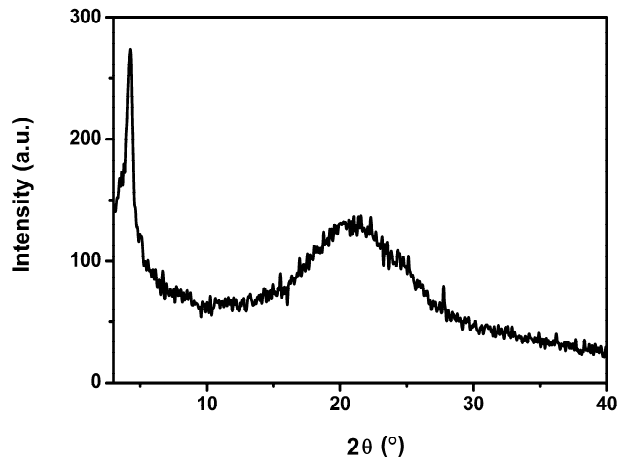
Figure 3. X-ray diffraction (XRD) pattern of PSTDPP film.